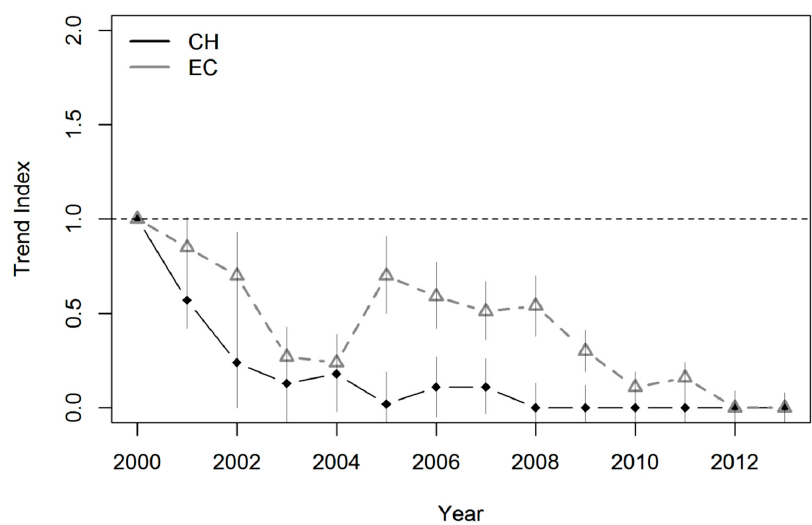
Figure 4. A significant ranch effect (EC: El Cuadro ranch; CH: Cerro Horqueta ranch) on the population trends of the culpeo fox in autumn. Population trends are based on the imputed trend indices estimated by a simple linear trend model (without change points; Supplementary Material Table S1). Vertical bars represent the SE of trend indices. The horizontal dashed line represents the index value for the base year (2000).